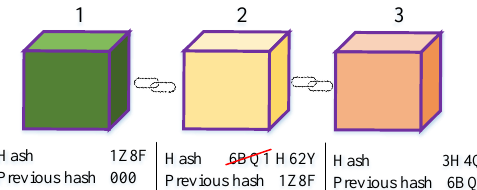
Figure 5. Blockchain’s anti-change mechanism